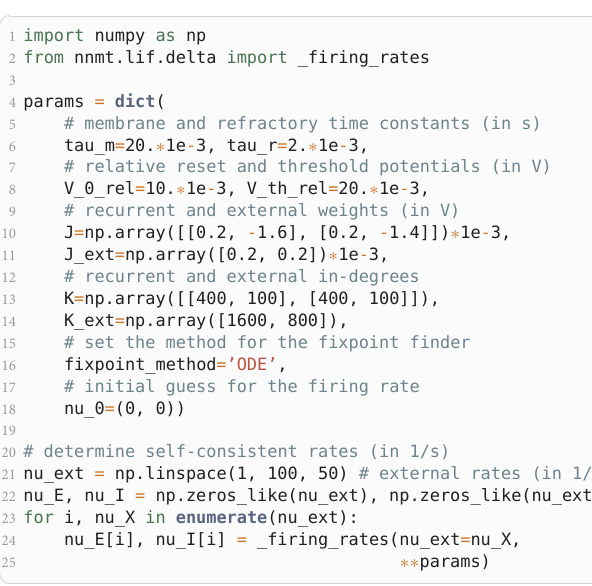
Listing 2: Example script to produce the data shown in Figure 2B using the ODE method (initial value ν a ,0 population a E , I ∈ { }